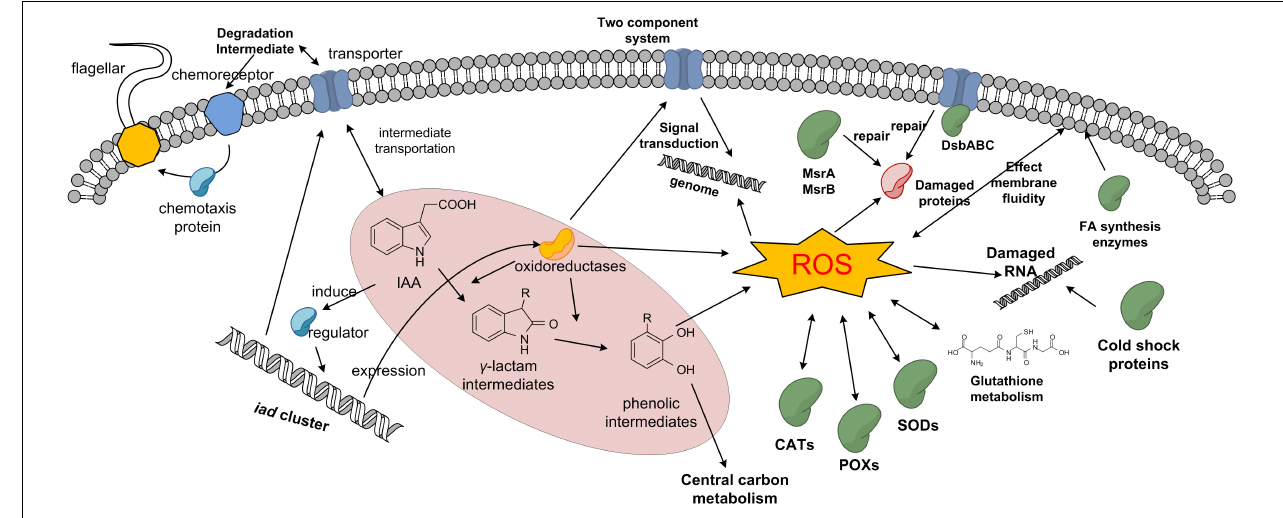
FIGURE 9 | Proposed protein profile of IAA degradation response in strain